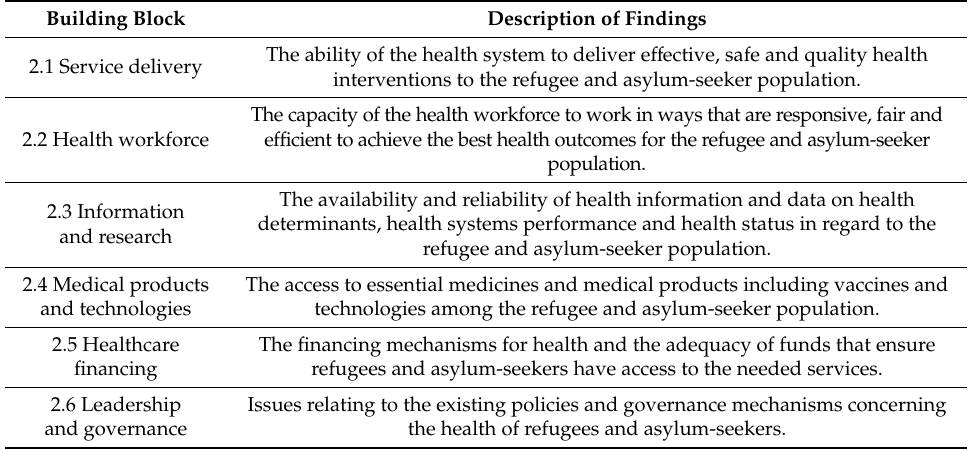
Table 3. DescriptionoffindingsaccordingtothesixbuildingblocksoftheWHOHealthSystemsFramework. Building